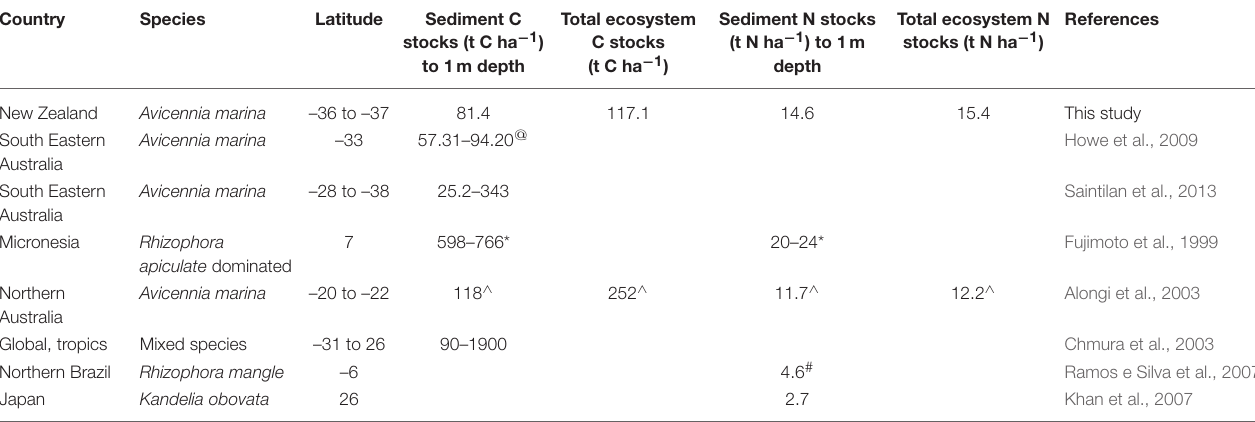
TABLE 4 | Sediment and total ecosystem stocks of carbon and nitrogen within mangrove forests.